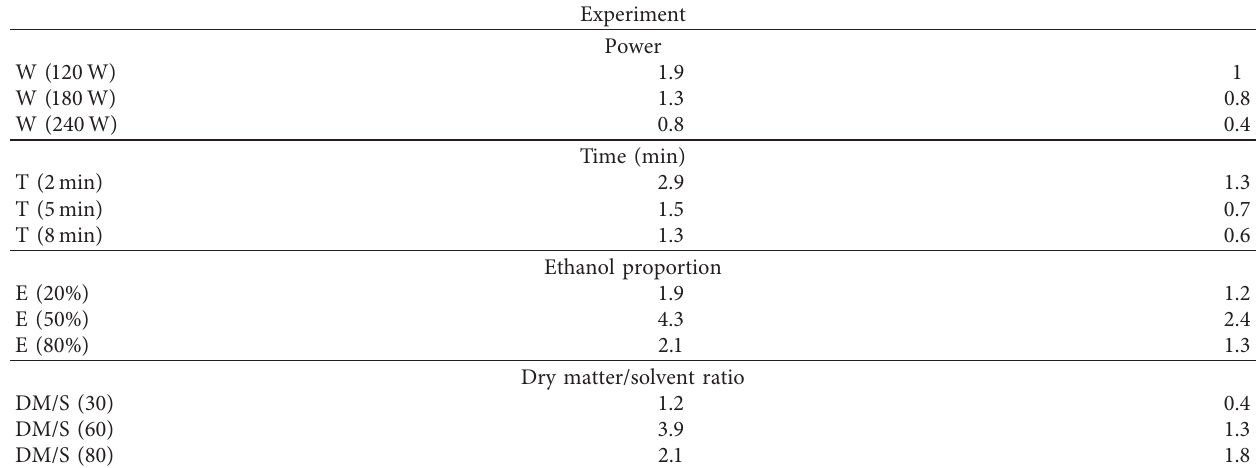
Table 3: Conditions and responses for the